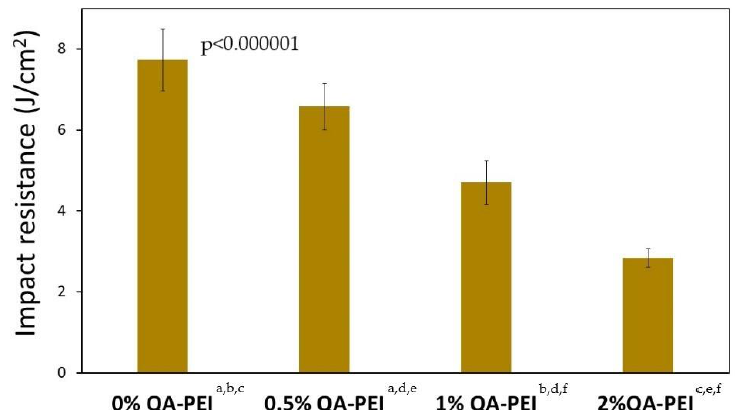
Figure 17. a n values of the materials. All the results for a n were statistically significant ( p ≤ 0.05) and they are marked with the lower case letters.